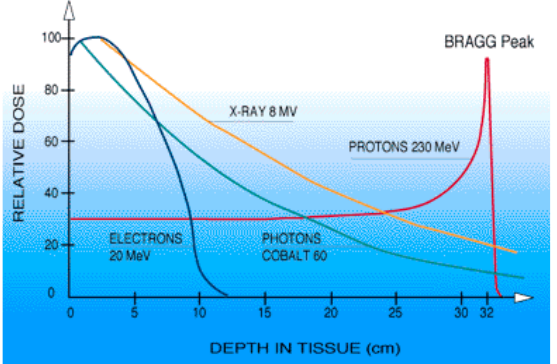
Figure 1. The relative radiation dose deposited as a function of tissue depth for various particle and photon